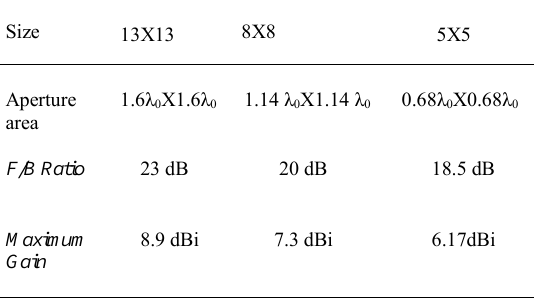
Table 1: Effect of variation in the size of the metamaterial Size 13X13 Aperture area